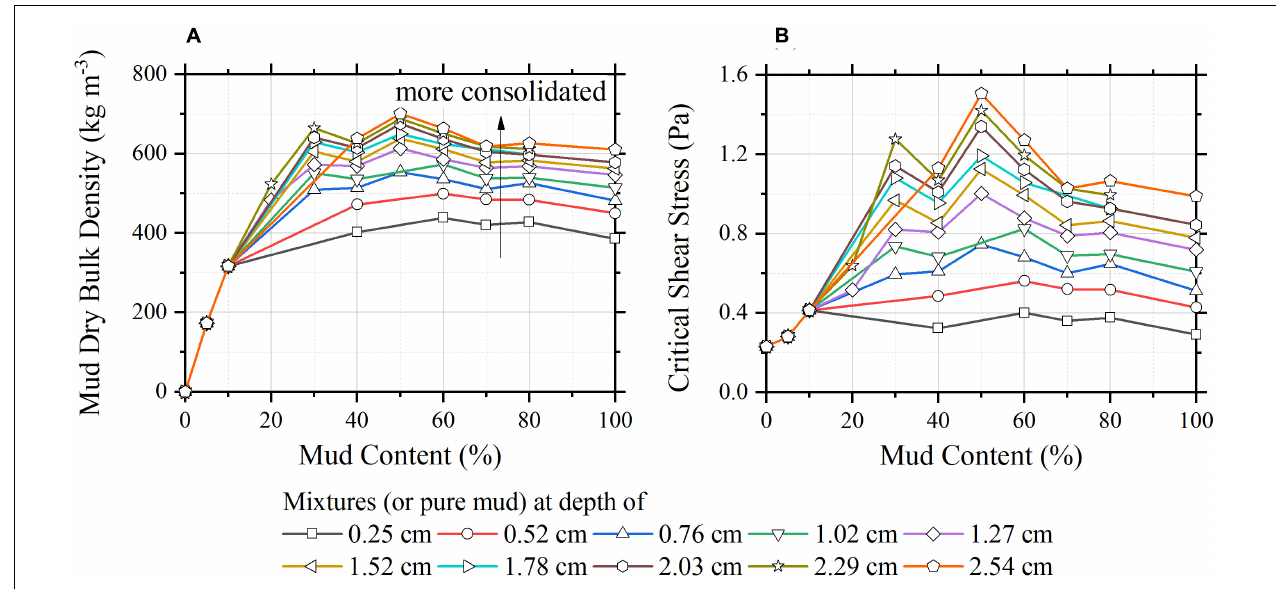
FIGURE 10 | The dry bulk density of the mud component (A) and the calculated critical shear stress (B) vary with mud content in the case of Sharif (2003).